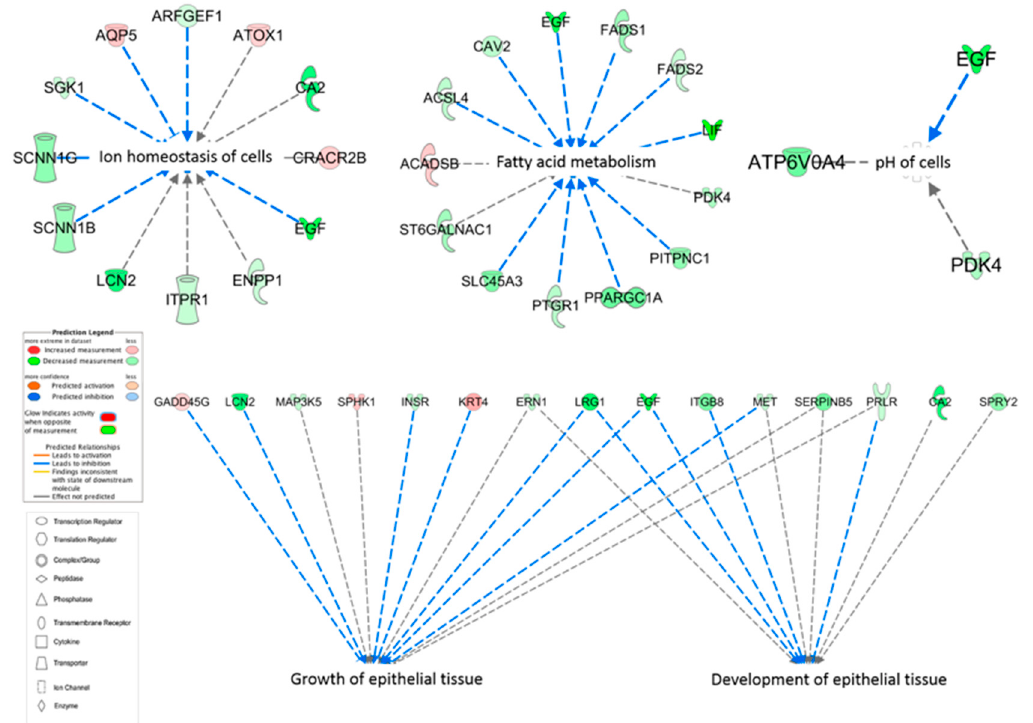
Figure 4. Ingenuity pathway analysis (IPA) of diseases and biological functions of the differentially expressed genes displayed as nodes (genes) and edges (biological relationship between nodes). The color intensity of each node represents fold change expression, red (upregulated), and green (downregulated). The edges connecting the genes to the respective functions represent the predicted relationships, blue representing inhibition and grey representing effect not predicted based on the IPA activation z-scores, combination of directional information encoded by the gene expression with information curated from the literature.